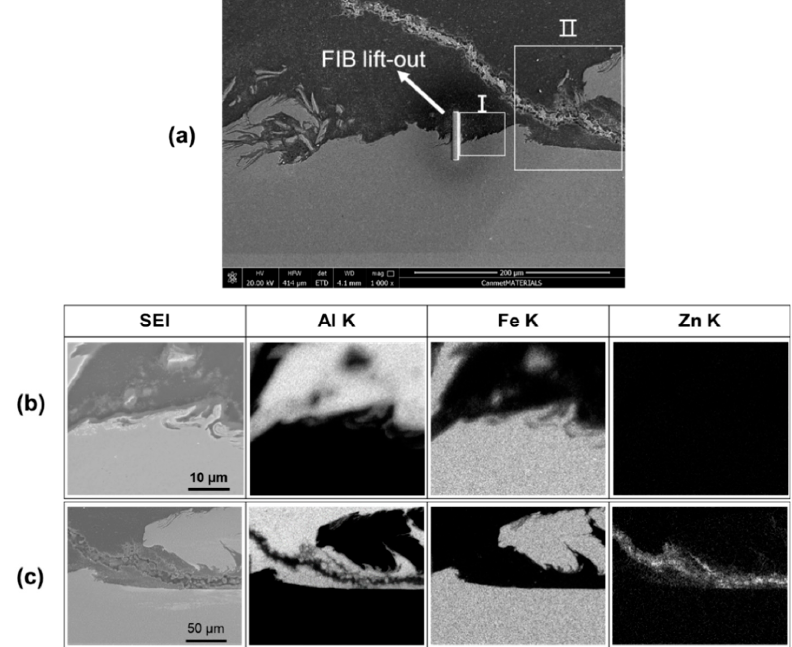
Figure 11. Hook zone at the retreating side of sample B: ( a ) SEM image of hook zone and energy dispersive X-ray spectrometry (EDS) element mapping of ( b ) region I and ( c ) region II.